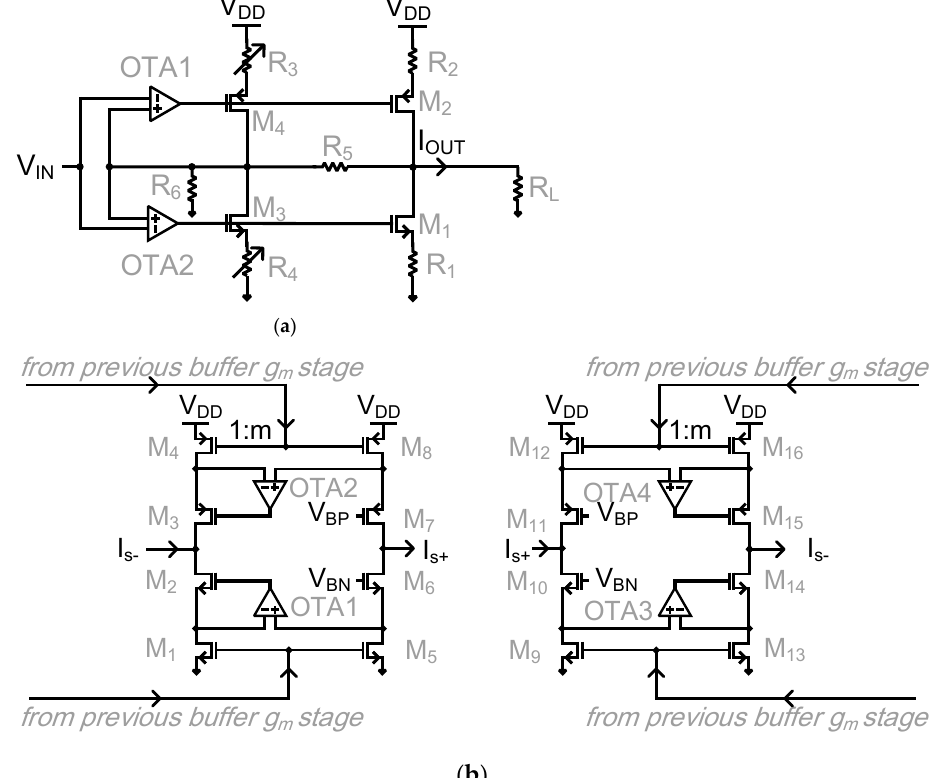
Figure 6. Conventional signal linearity enhancement and signal gain control techniques. ( a ) Line driver using error amplifiers and tunable current mirrors [1]. ( b ) A current-mode H-bridge class-AB output stage with auxiliary amplifiers [8].